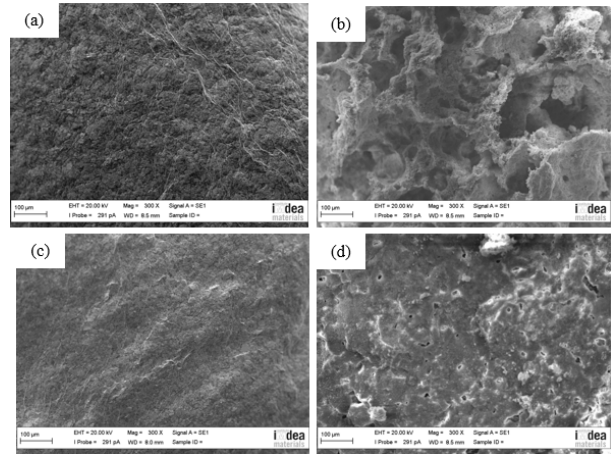
Figure 6. SEM images of charred residue of flame-retardant PP composites: ( a ) PP-1; ( b ) PP-3; ( c ) PP-4; ( d ) PP-6.